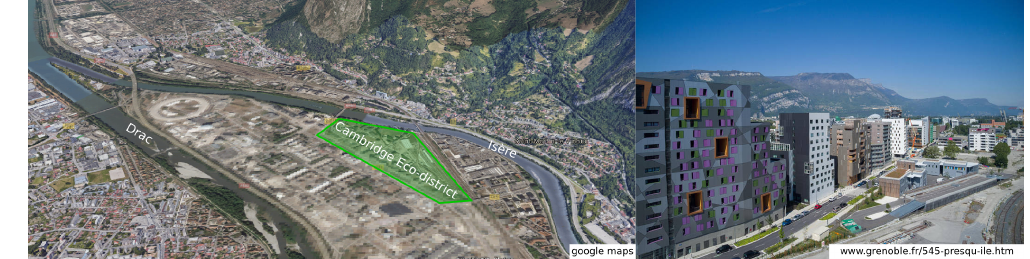
Figure 1. Illustration of the district thermal fed by a groundwater source.